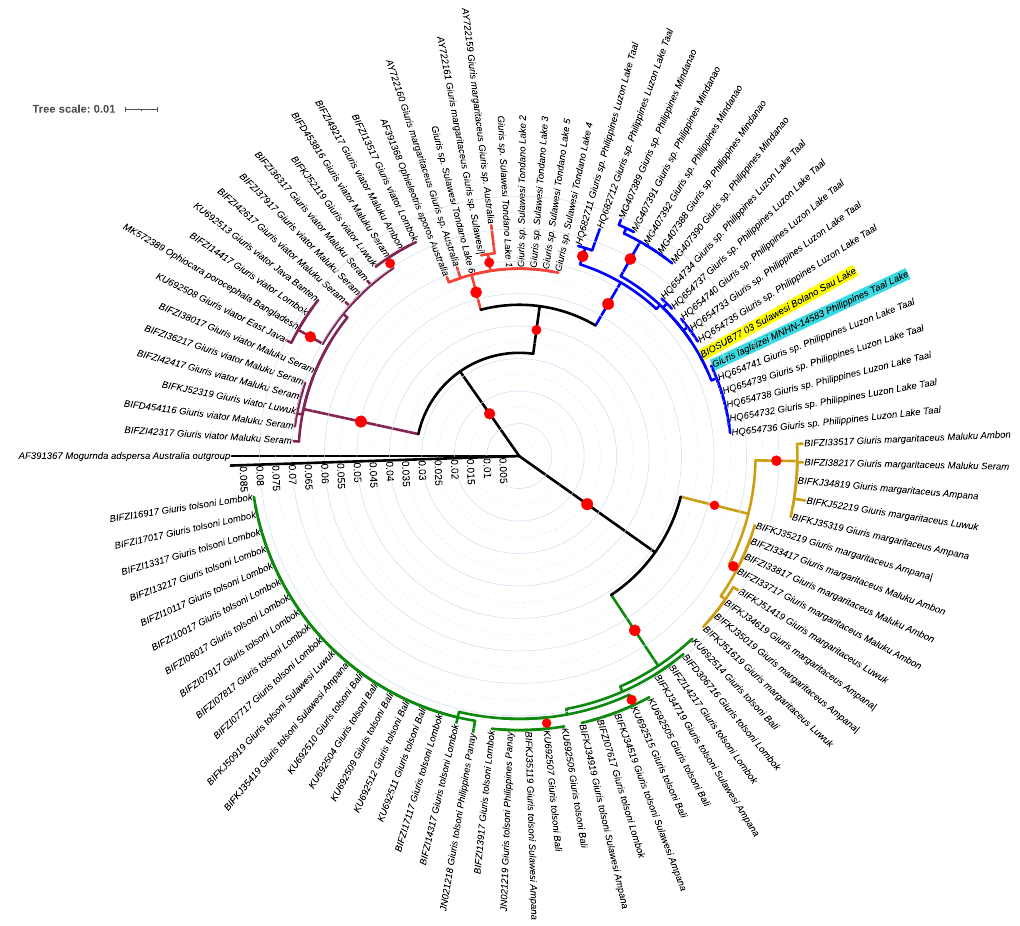
Figure 4. Evolutionary relationships of the genus Giuris , with Mogurnda adspersa as outgroup. The Bolano Sau Lake payangka sequence is highlighted in yellow and the Giuris laglaizei sequence MNHN-14583 from Philippe Keith is highlighted in turquoise. The Maximum Likelihood analysis in MEGA X 62 included 94 sequences with 580 positions and100 bootstrap replicates.Thered circlesindicatenodebootstrap values over75%. Thebranchscaleis innumber of substitutions per site. Accession/Record details: see Table